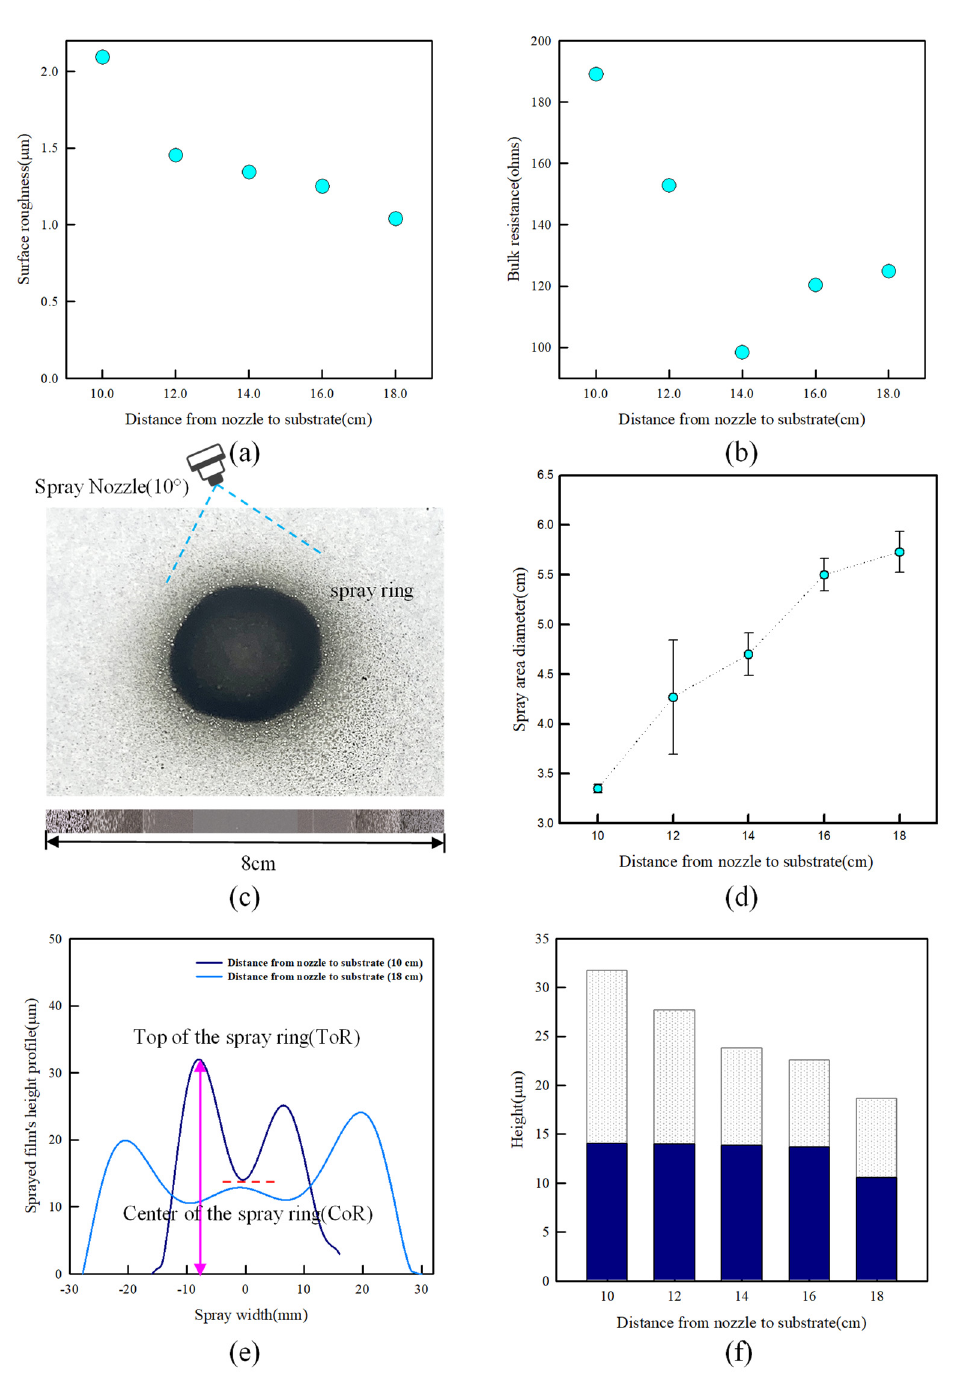
Figure 7. Effect of distance of nozzle to substrate in ( a ) surface roughness, ( b ) bulk resistance, ( c ) ring image in DNS 10 cm, ( d ) spray ring diameter, ( e ) height profile of spray ring, and ( f ) a comparison of ToR and CoR.